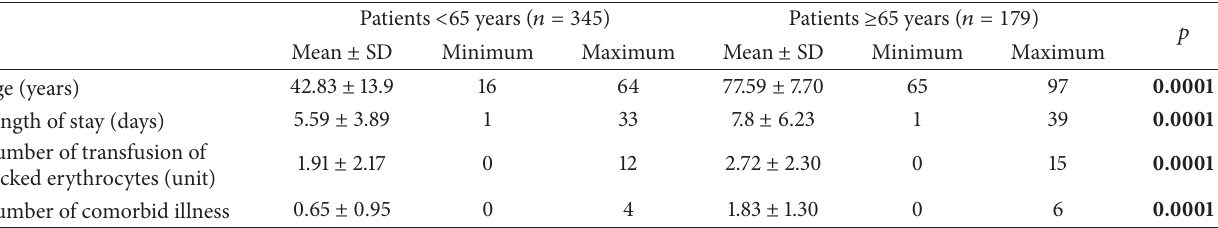
Table1:Comparisonofpatients < 65yearsandpatients ≥ 65yearsinregardtoage,lengthofstay,numberoftransfusionofpackederythrocytes, and number of comorbid